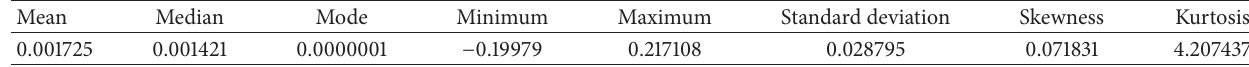
Table 1: Daily returns in ISE 100 index, basic statistics.